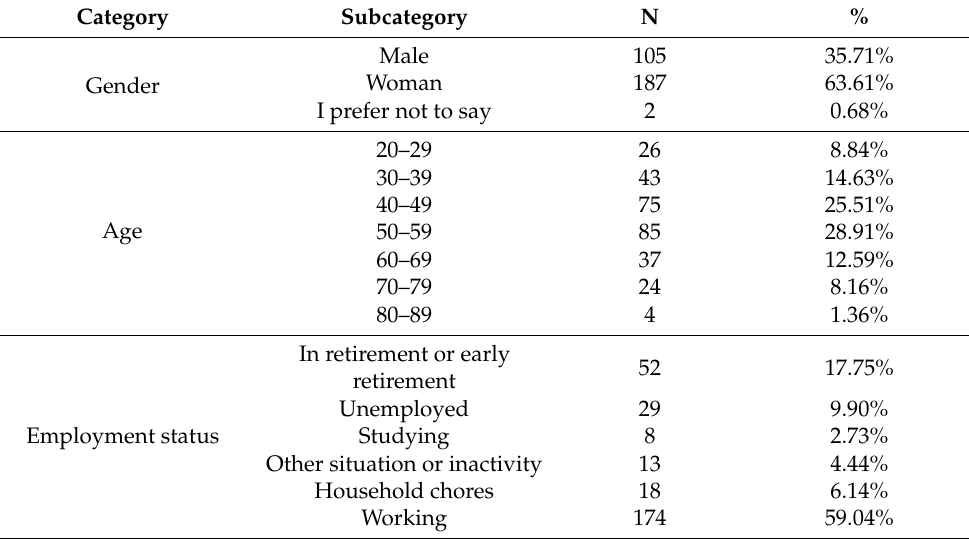
Table 2. Survey sample by